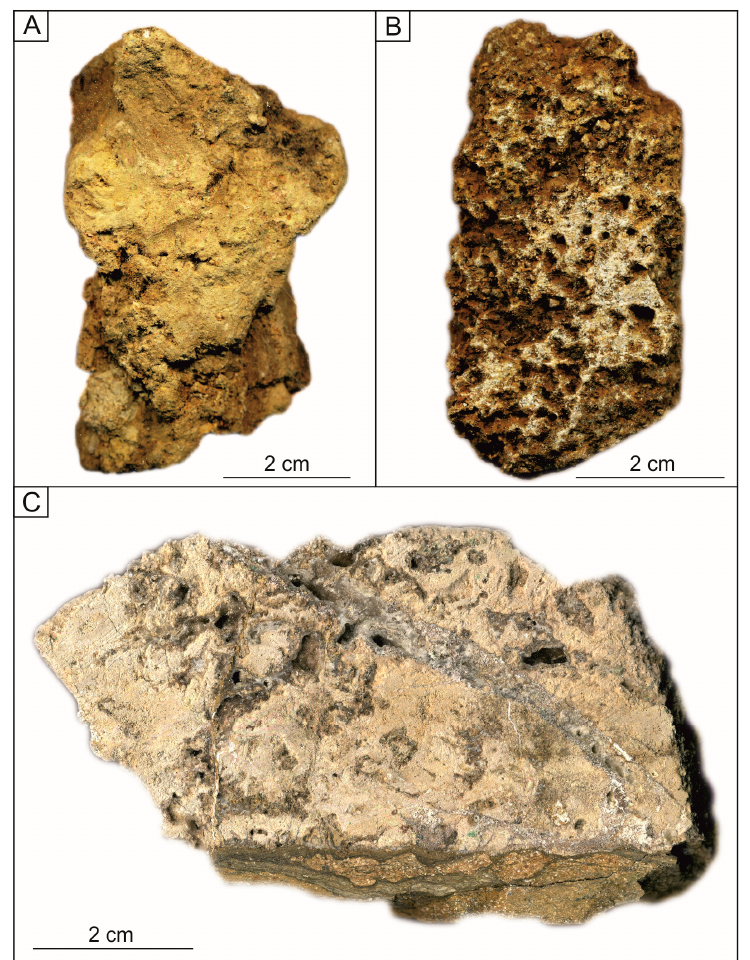
Figure 2. Examples of analyzed specimens from Cristal ( A ) CR07-14; ( B ) CR13-7 and Mina Grande ( C ) ZB-2 deposits.